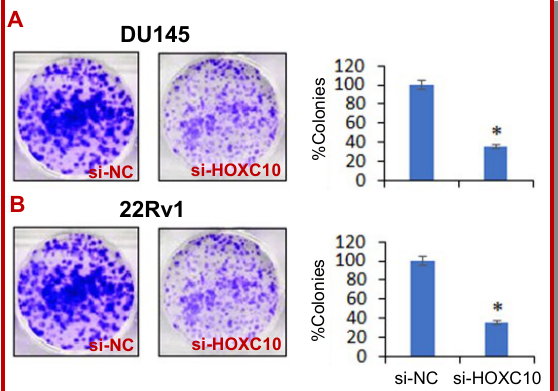
Figure 4: Silencing of HOXC10 transcript levels induces apop- tosis of prostate cancer cells. (A) DAPI staining showing the induction of apoptosis in si-NC and si-HOXC10 transfected DU145 prostate cancer cells; (B) DAPI staining showing the induction of apoptosis in si-NC and si-HOXC10 transfected 22Rv1 prostate cancer cells. The experiments were performed in triplicates and expressed as mean ± SD (*p<0.05)